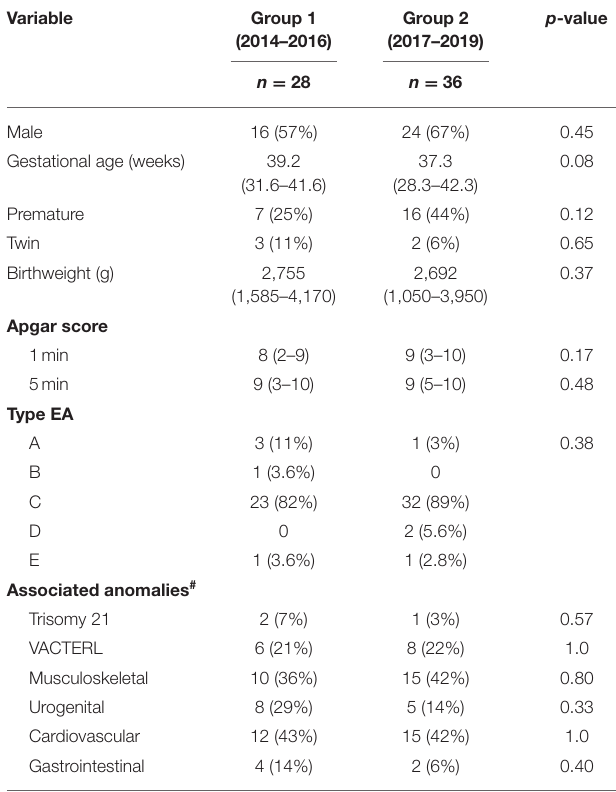
their decision on symptpoms and/or chest X-rays. Antibiotic